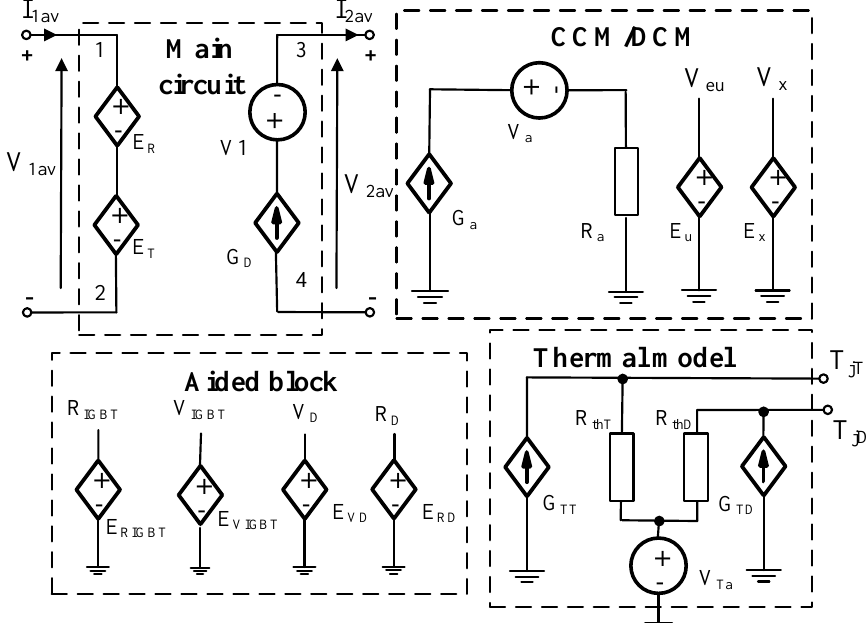
Figure 2. Network representation of the electrothermal averaged model of a diode–transistor switch (DTS) including IGBT and a diode.